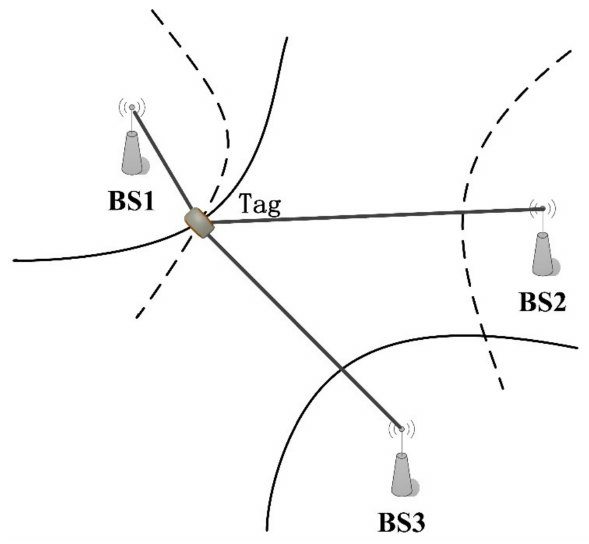
Figure 1. UWB TDOA location principle in 2D